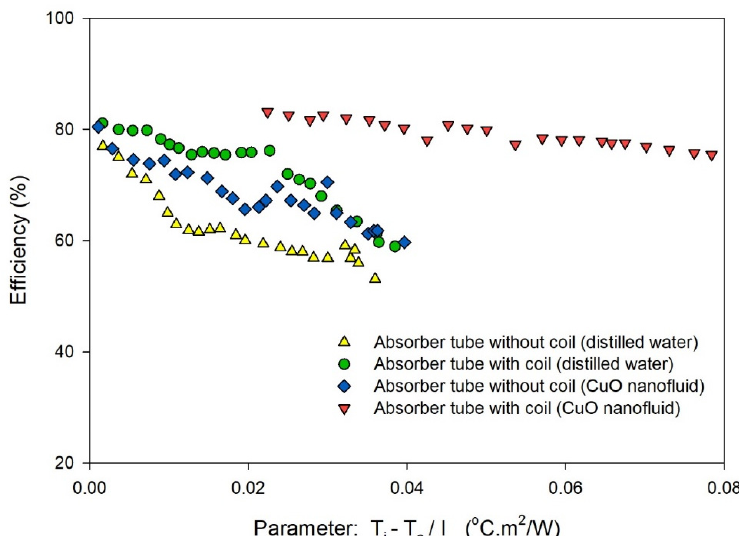
Figure 5. Thermal efficiency analyses of absorber tube without coil and with coil using distilled water and CuO nanofluid as heating medium flowing at rate of 6 L/min.